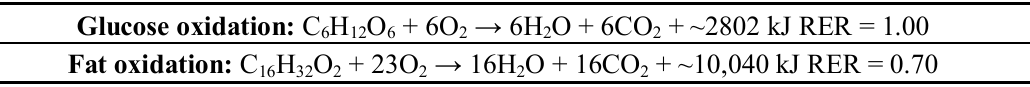
Table 1. Glucose and fat